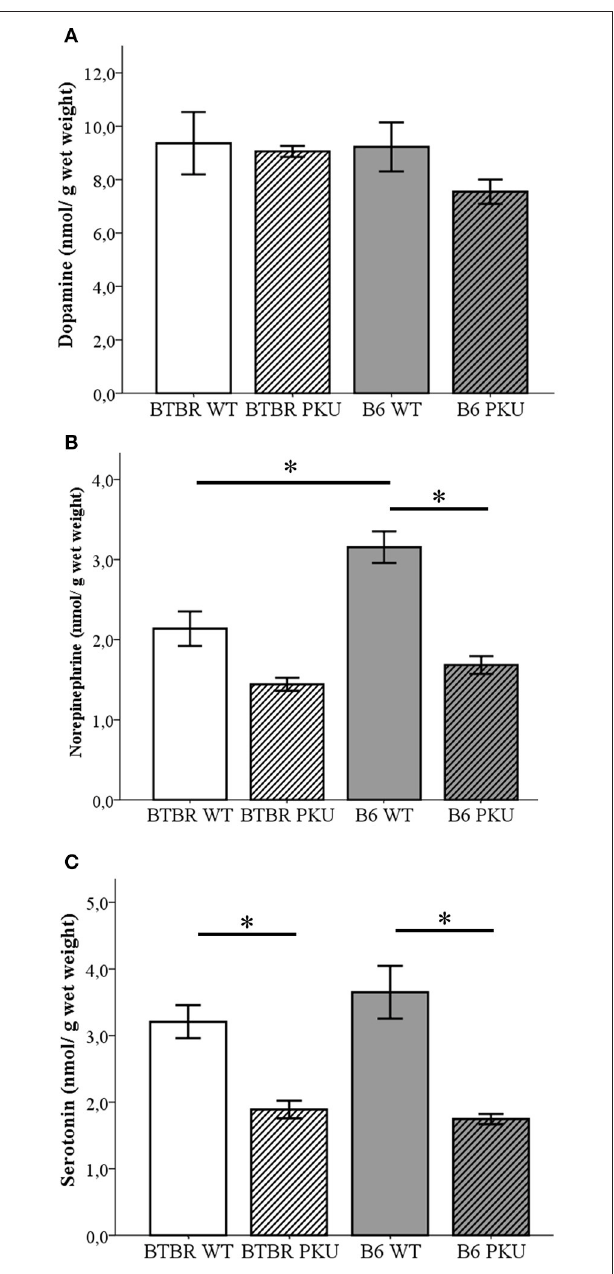
FIGURE 3 | Neurotransmitter analyses. (A) Dopamine, (B) norepinephrine, (C) serotonin ( n = 6 for all groups except for BTBR PKU n = 5). * p ≤ 0.05; mean ±